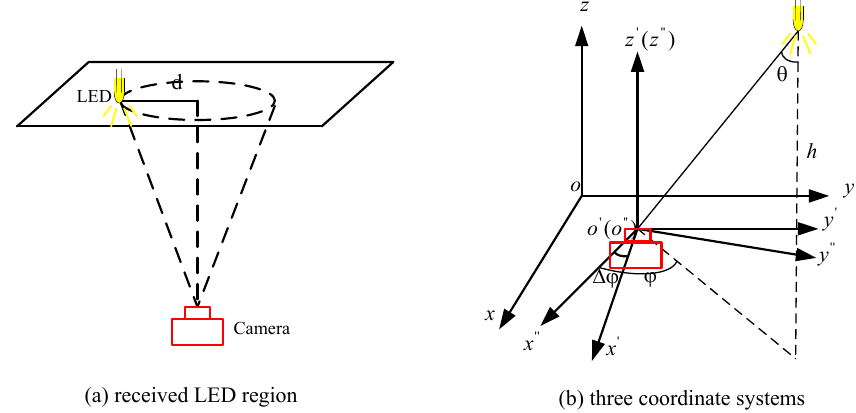
Figure 1. Schematic diagram of the horizontal reception mode.